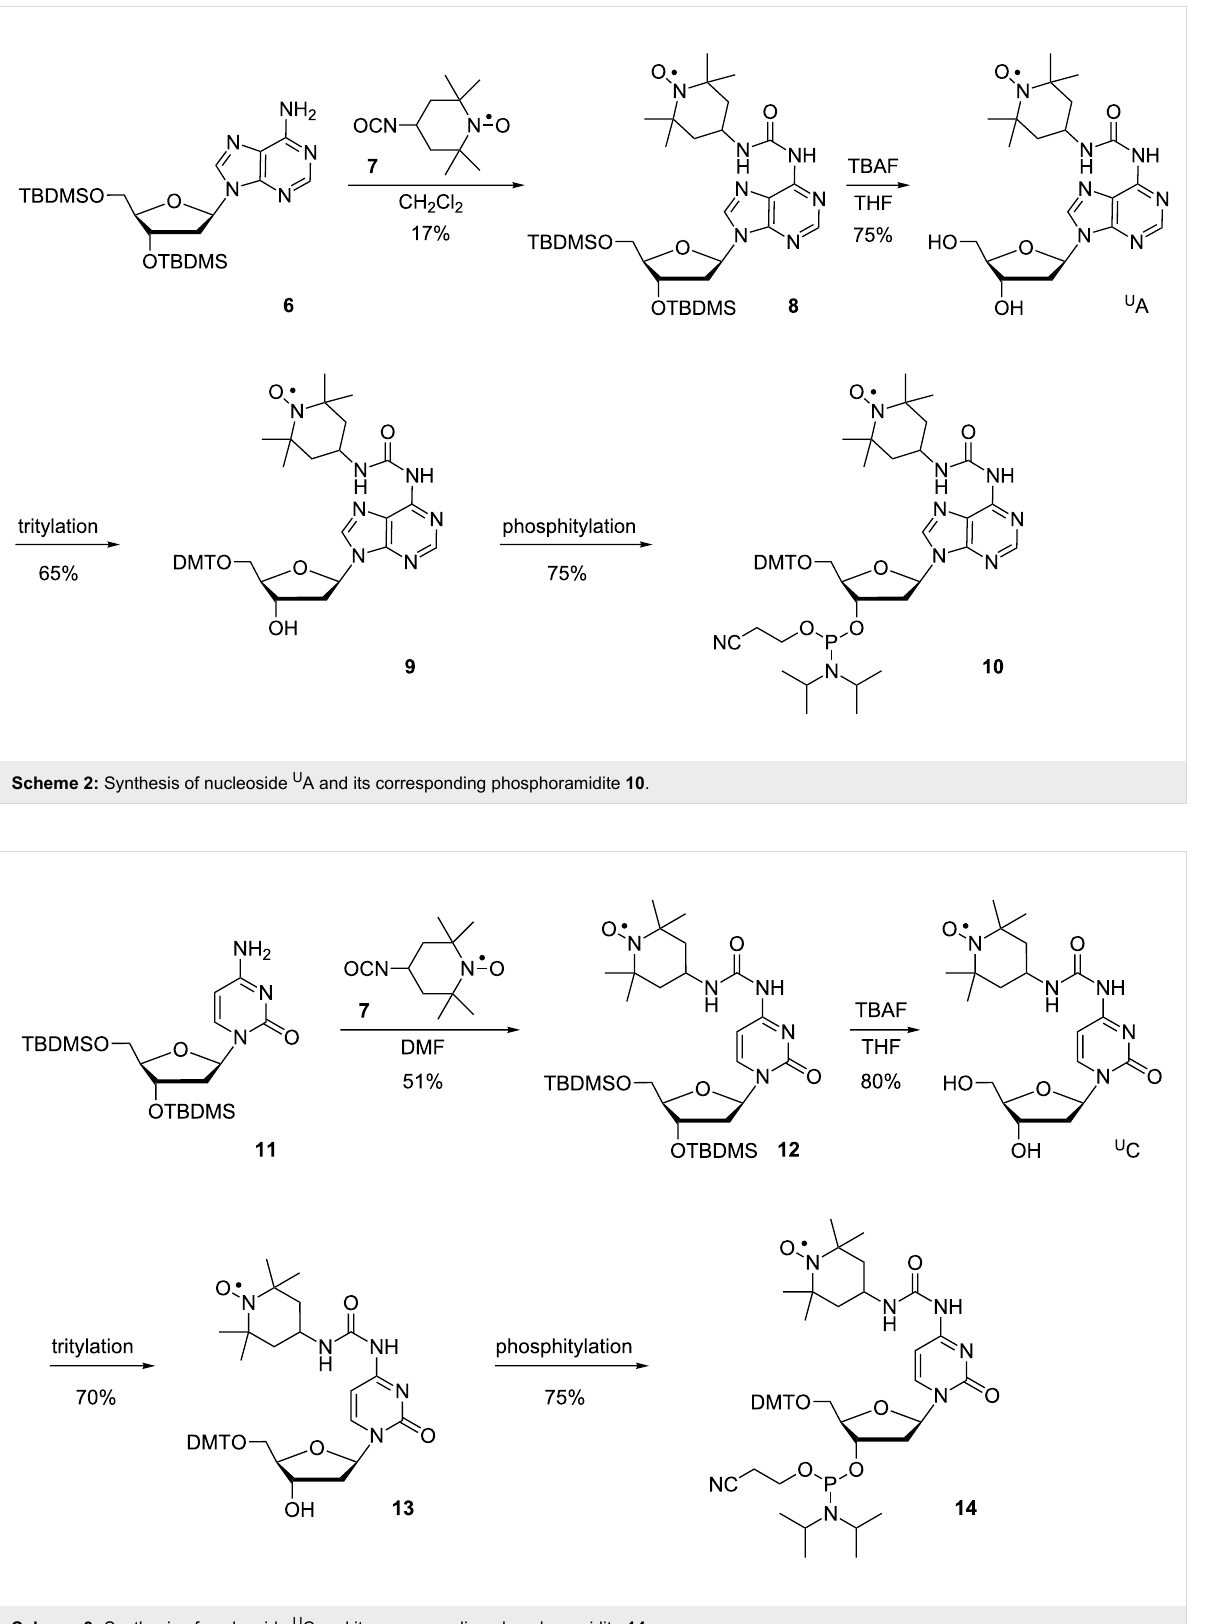
Scheme 3: Synthesis of nucleoside U C and its corresponding phosphoramidite 14